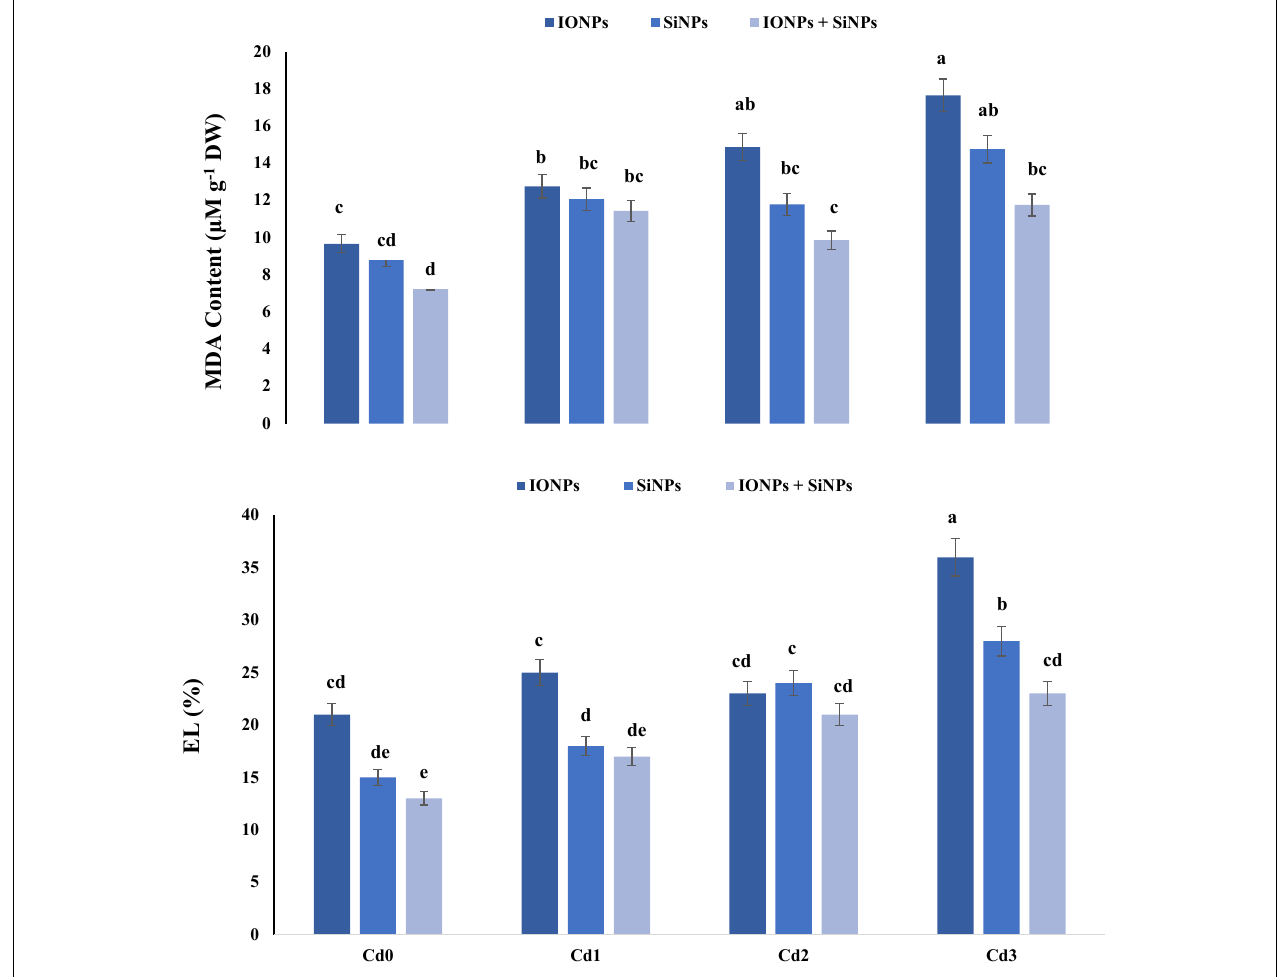
FIGURE 2 | Effect of IONPs and SiNPs on MDA content and EL of Phaseolus vulgaris grown in different concentrations of Cd. Here IONPs, SiNPs, Cd0, Cd1, Cd2, and Cd3 indicate iron oxide nanoparticles, silicon nanoparticles, 0 mM CdCl 2 , 1 mM CdCl 2 , 1.5 mM CdCl 2 , and 2 mM CdCl 2 . Different letters indicate significant difference among the treatments ( P ≤